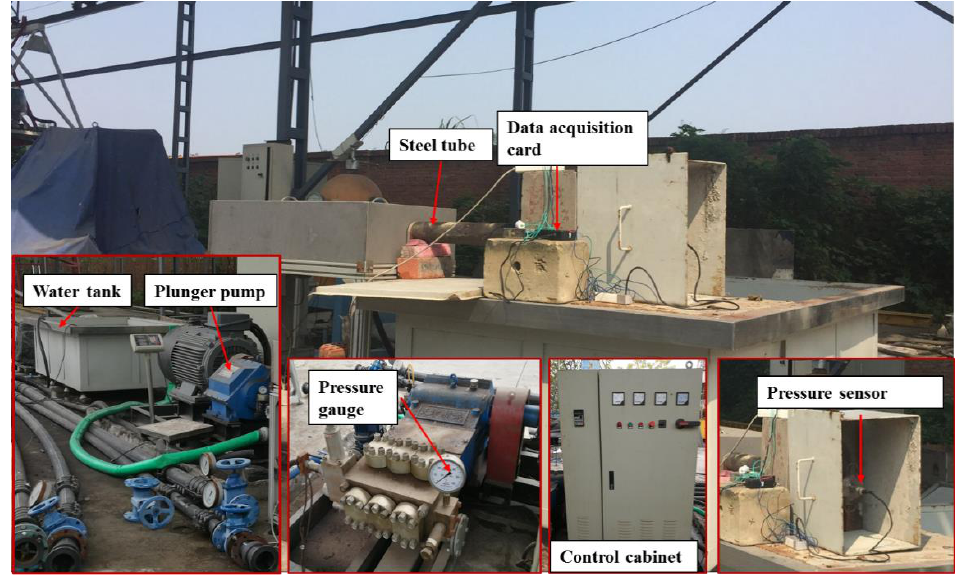
Figure 4. High-pressure water jet measurement system.